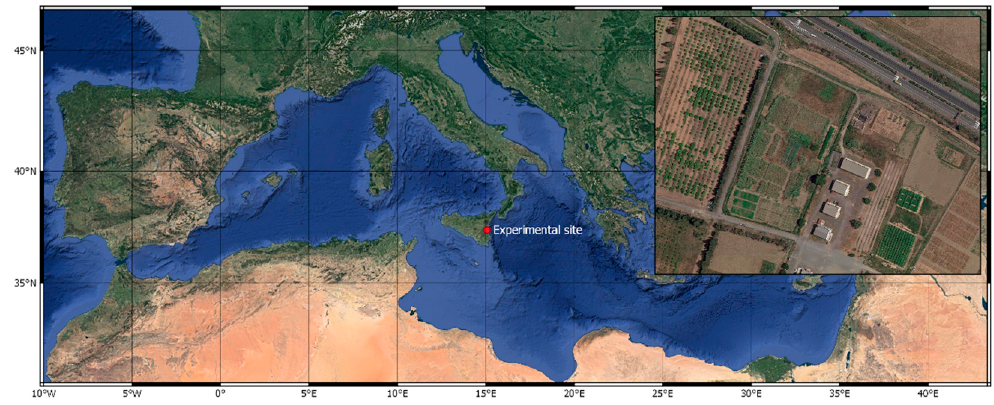
Figure 1. Experimental Farm of the University of Catania located in south-eastern Sicily, Italy (10 m a.s.l., 37°24’35.8” N lat., 15°03’31.7” E long.).